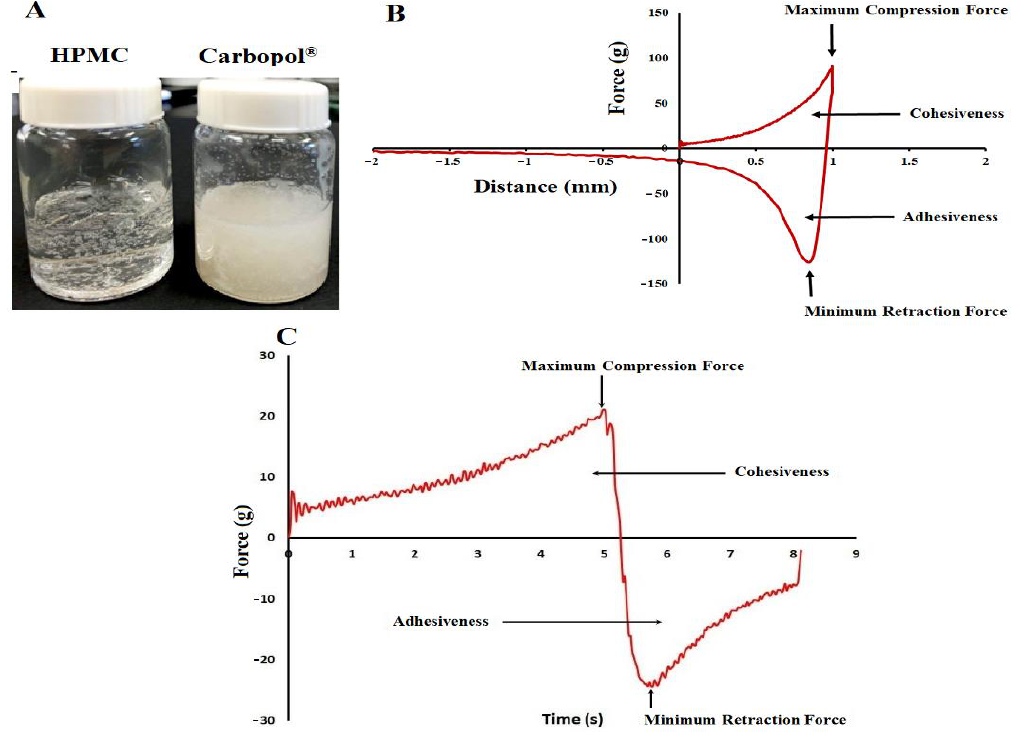
Figure 4. ( A ) Formulation of desloratadine hydrogel using various polymers. ( B ) Force distance profile of the gel. ( C ) Force time profile of the gel. Data are shown as mean ± SD, n = 6.